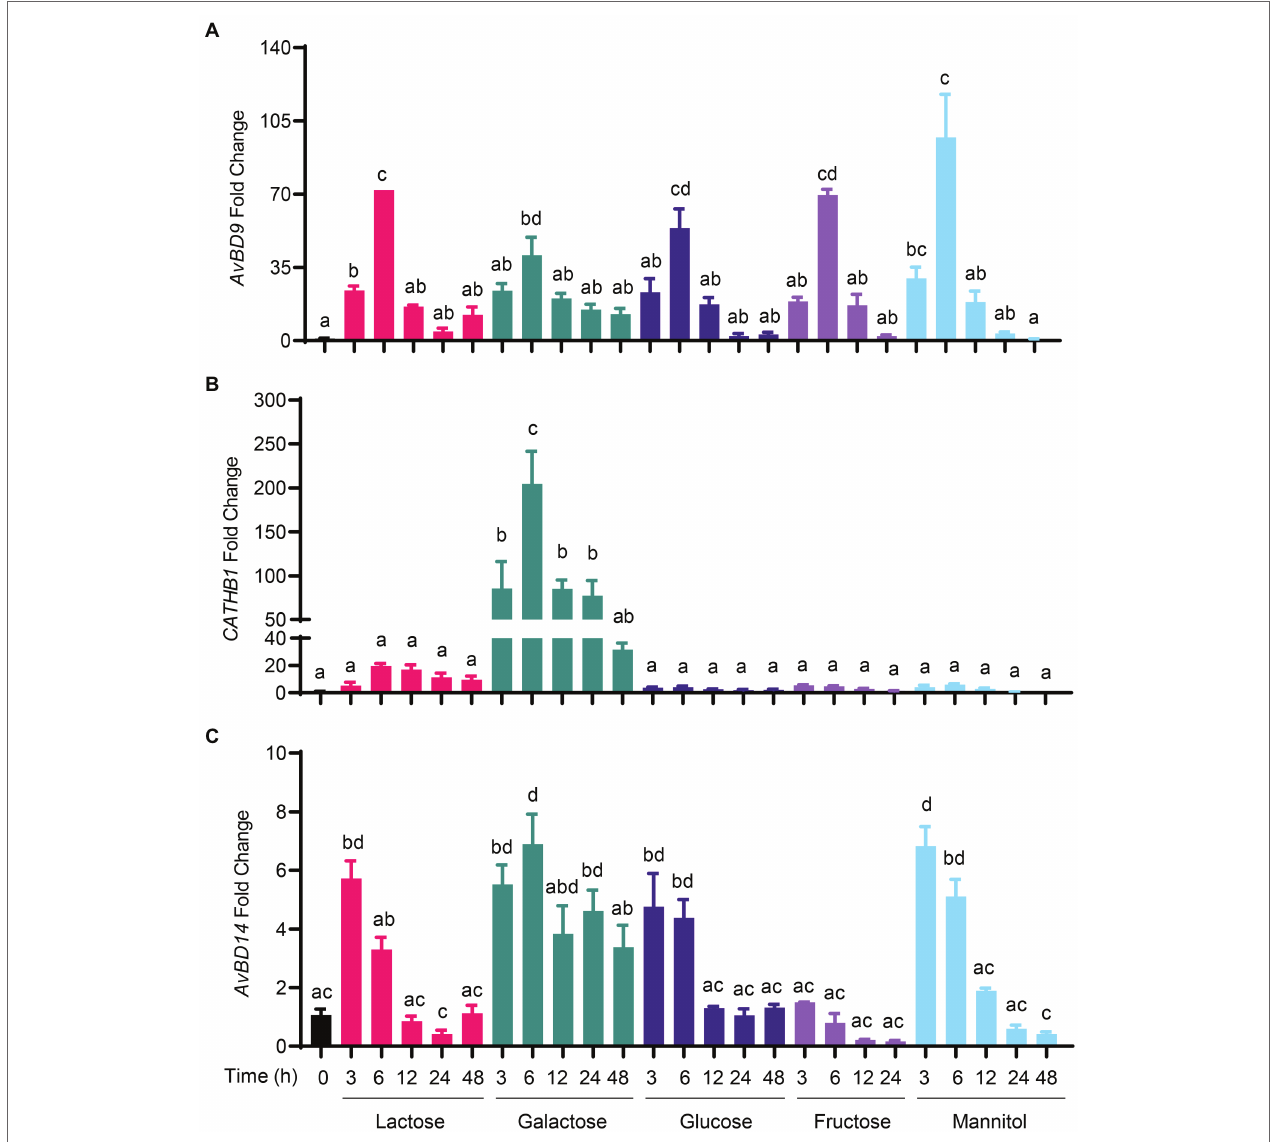
FIGURE 2 | Time-dependent induction of host defense peptide (HDP) expression by sugars. Chicken HD11 macrophages were stimulated in duplicate with 0.2 M of indicated sugars for 3, 6, 12, 24, or 48 h. Cells were then subjected to RNA isolation and RT-qPCR analysis of gene expressions of avian β -defensin 9 ( AvBD9